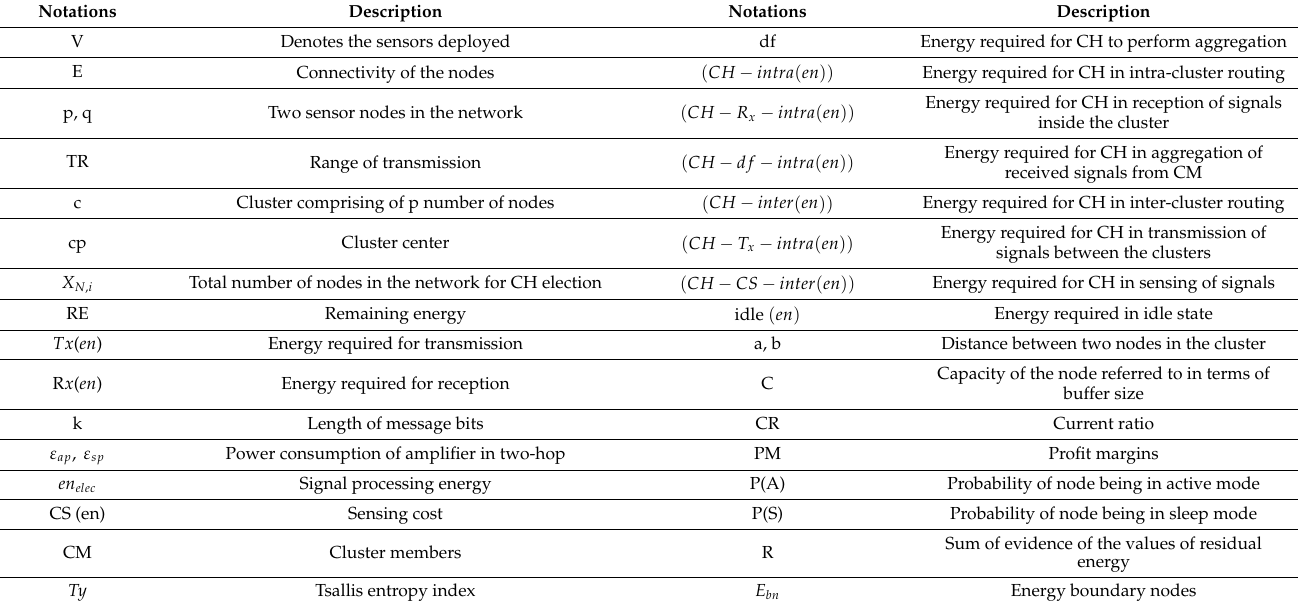
Table 2. Notations